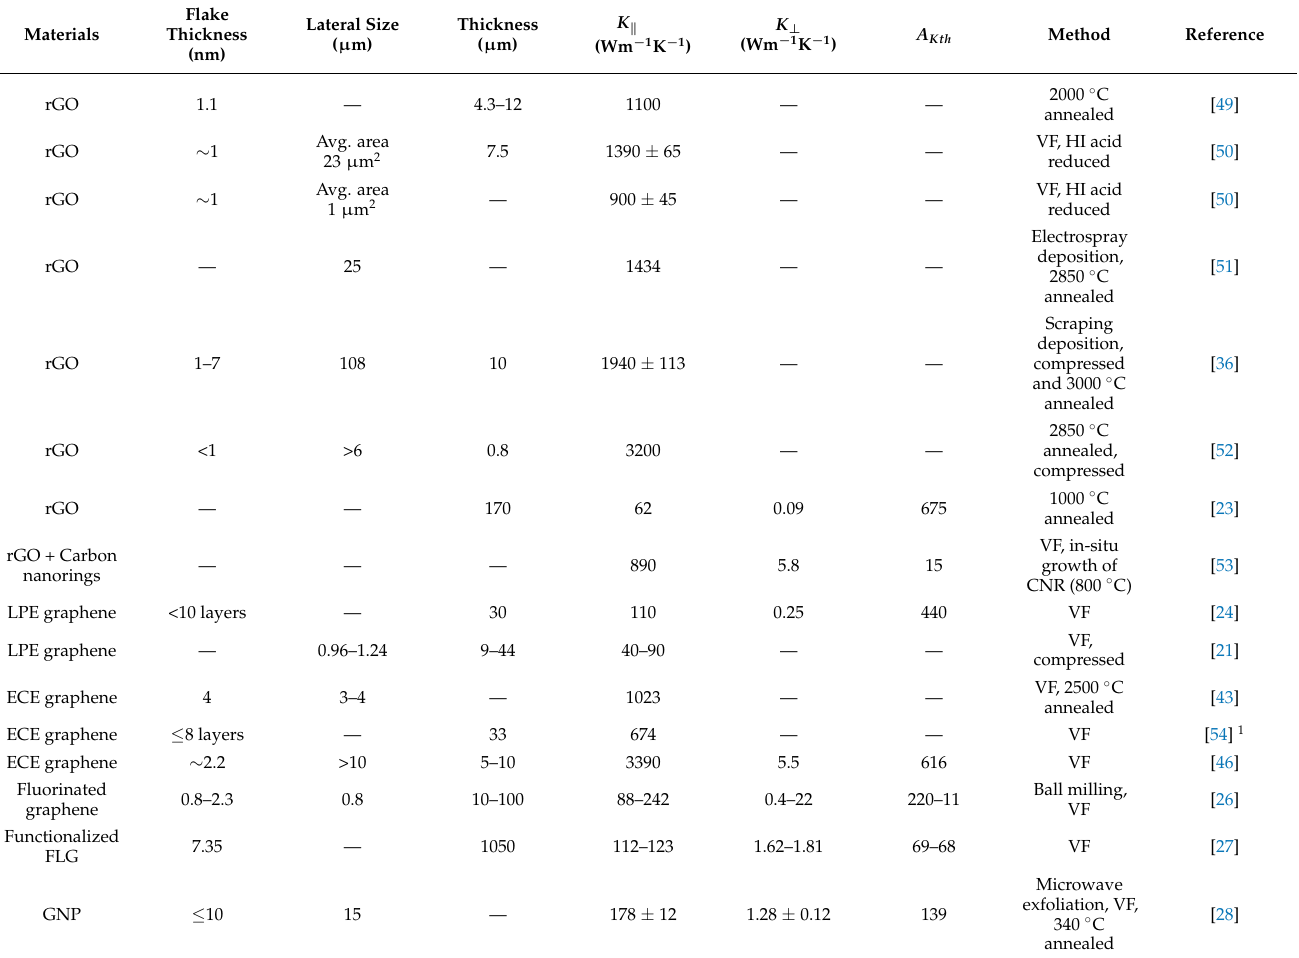
Table 1. Summary table of reported thermal conductivity for films made by solution processing. In the table, the following abbreviations are used: rGO for reduced graphene oxide, LPE for liquid-phase exfoliation, ECE for electro-chemical exfoliation, FLG for few-layer graphene, GNP for